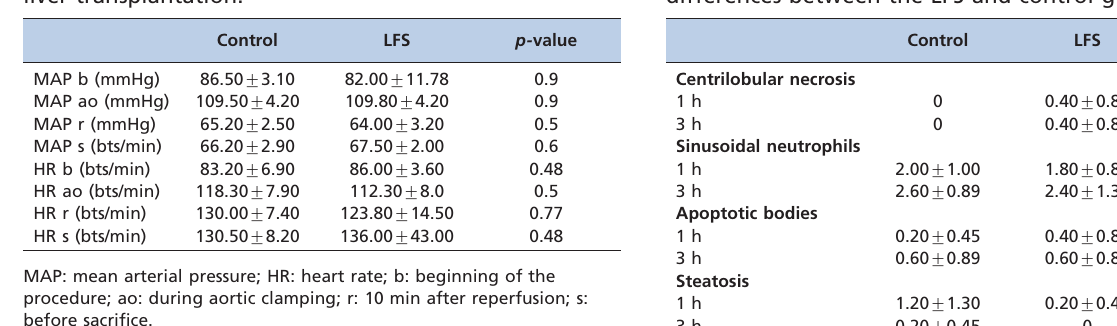
Table 2 - Hemodynamic data during the experimental liver transplantation.